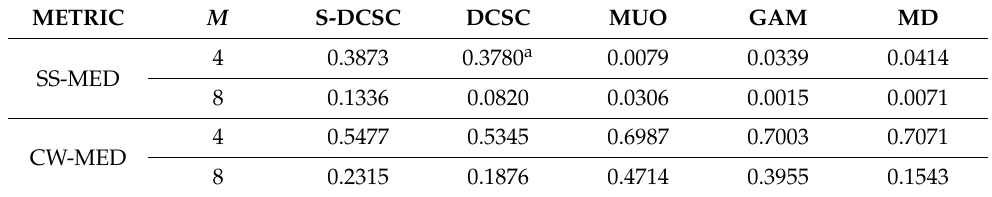
Table 1. The SS-MED and CW-MED of different codebook design schemes.